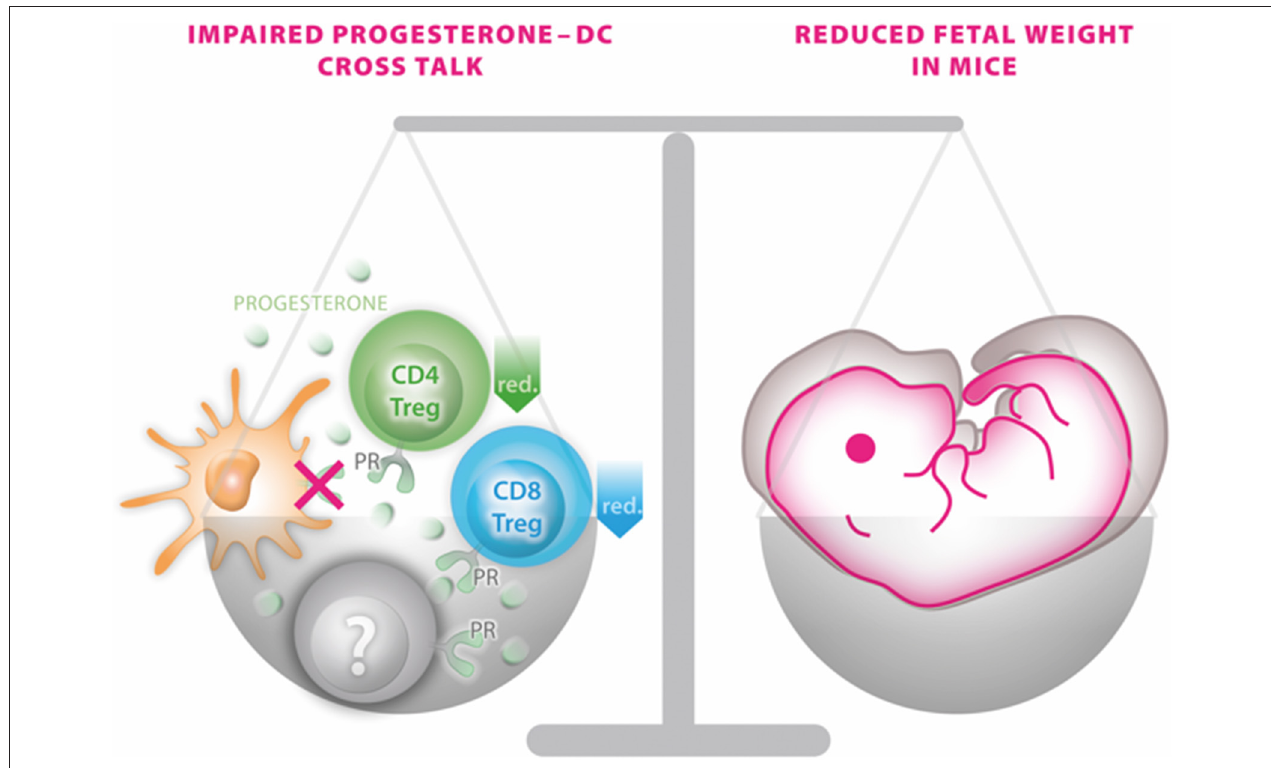
FIGURE 6 | Graphical scenario depicting the impact of the selective knockout of the progesterone receptor on CD11c + dendritic cells (DCs) and its consequences for fetal growth. An impaired progesterone-DC cross talk disturbs the fine-tuned balance of a functional immune response of DCs to progesterone by affecting CD4 and CD8 Treg populations (and potentially also on yet to be identified immune cells marked in gray) on one site and fetal outcome on the other